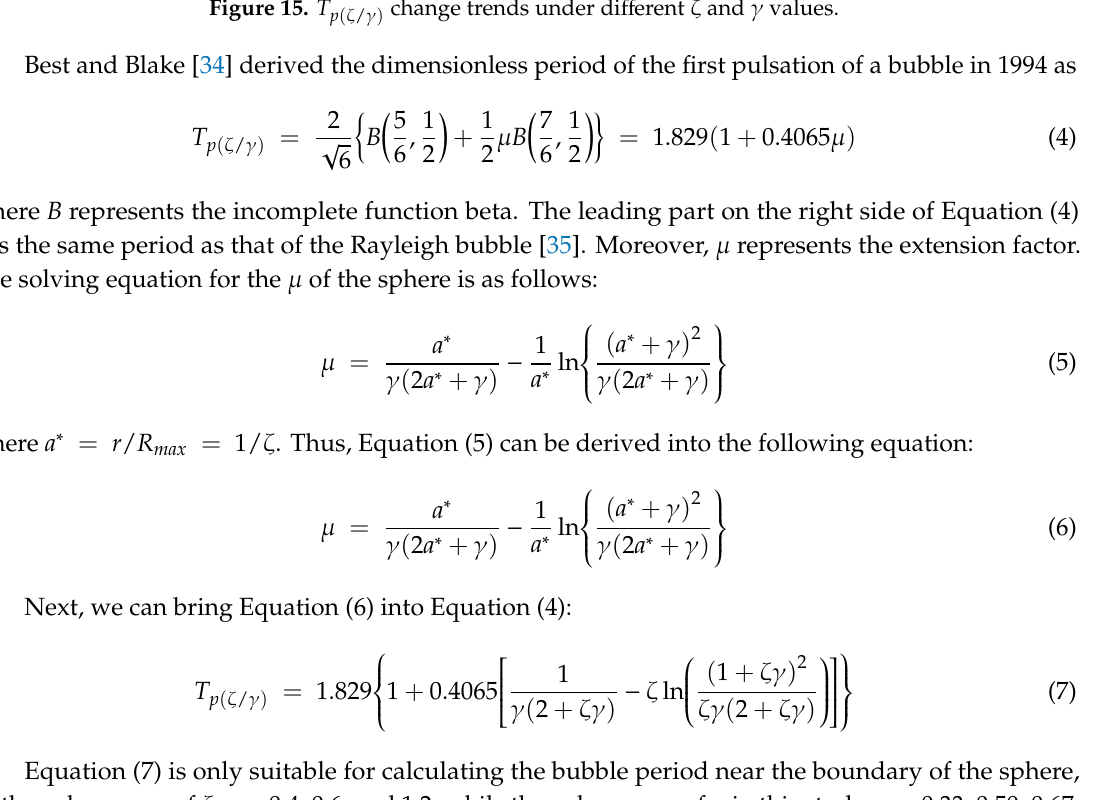
Figure 15. T p ( ζ / γ ) change trends under di ff erent ζ and γ